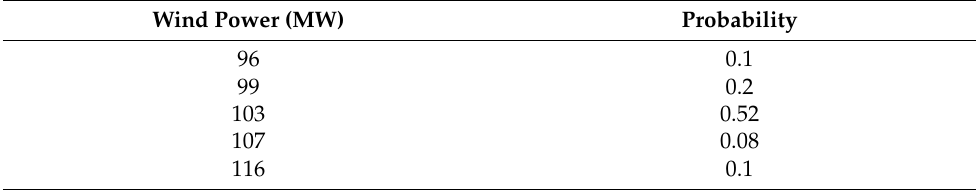
Figure 7. The probability density function of wind power at different prediction time points. Table 2. Wind-power output value and corresponding